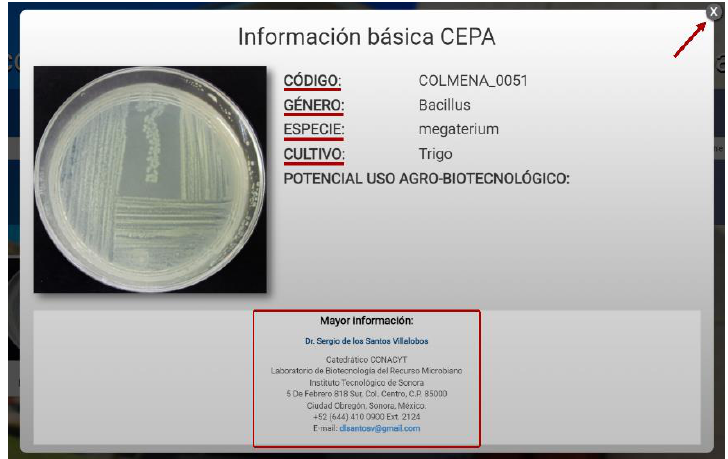
Figure 7. Basic information about the